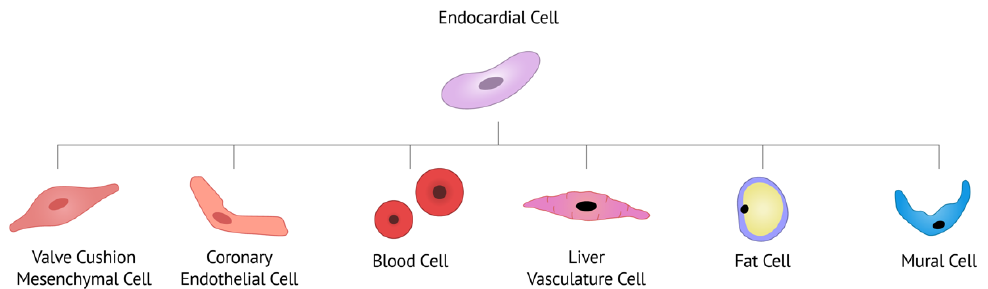
Figure 2. Known endocardial cell lineages, adapted from Zhang et al. [31]. Endocardial cells can develop into valve cushion mesenchymal cells (VICs), coronary endothelial cells, blood cells, liver vasculature cells, fat cells, and mural cells (potentially via “intermediate” cushion